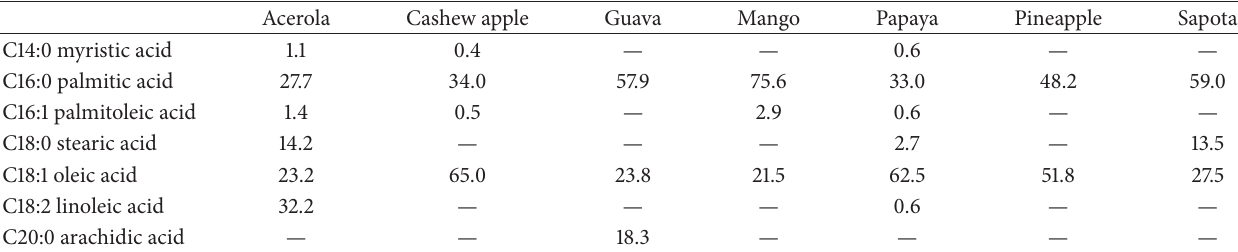
Table 2: Fatty acids composition in seven fruit